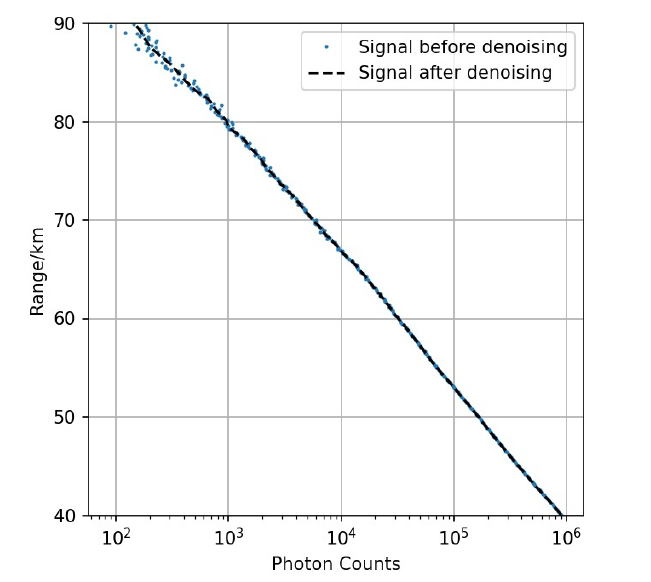
Figure 10. The noisy echo signal and the signal after denoising of ground-based lidar.